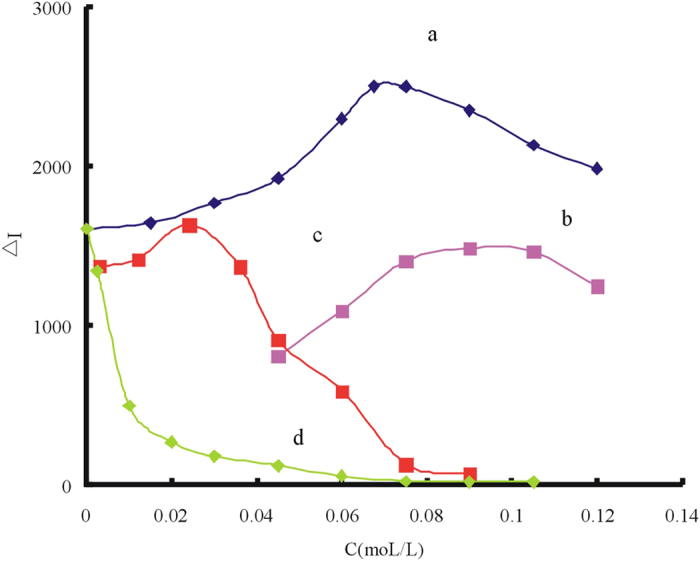
Influence of the reaction medium(a) HAc -1 × 10−4 mol/L AgNR -75 nmol/L Hg(II)-20 mmol/L NaCl-1.5 × 10−7mol/L VBB; (b) HCl -1 × 10−4mol/L AgNR -75 nmol/L Hg(II)-20 mmol/L NaCl-1.5 × 10−7mol/L VBB; (c) H2SO4 -1 × 10−4mol/L AgNR -75 nmol/L Hg(II)-20 mmol/L NaCl-1.5 × 10−7mol/L VBB; (d) NaOH -1 × 10−4mol/L AgNR -75 nmol/L Hg(II)-20 mmol/L NaCl-1.5 × 10−7mol/L VBB.